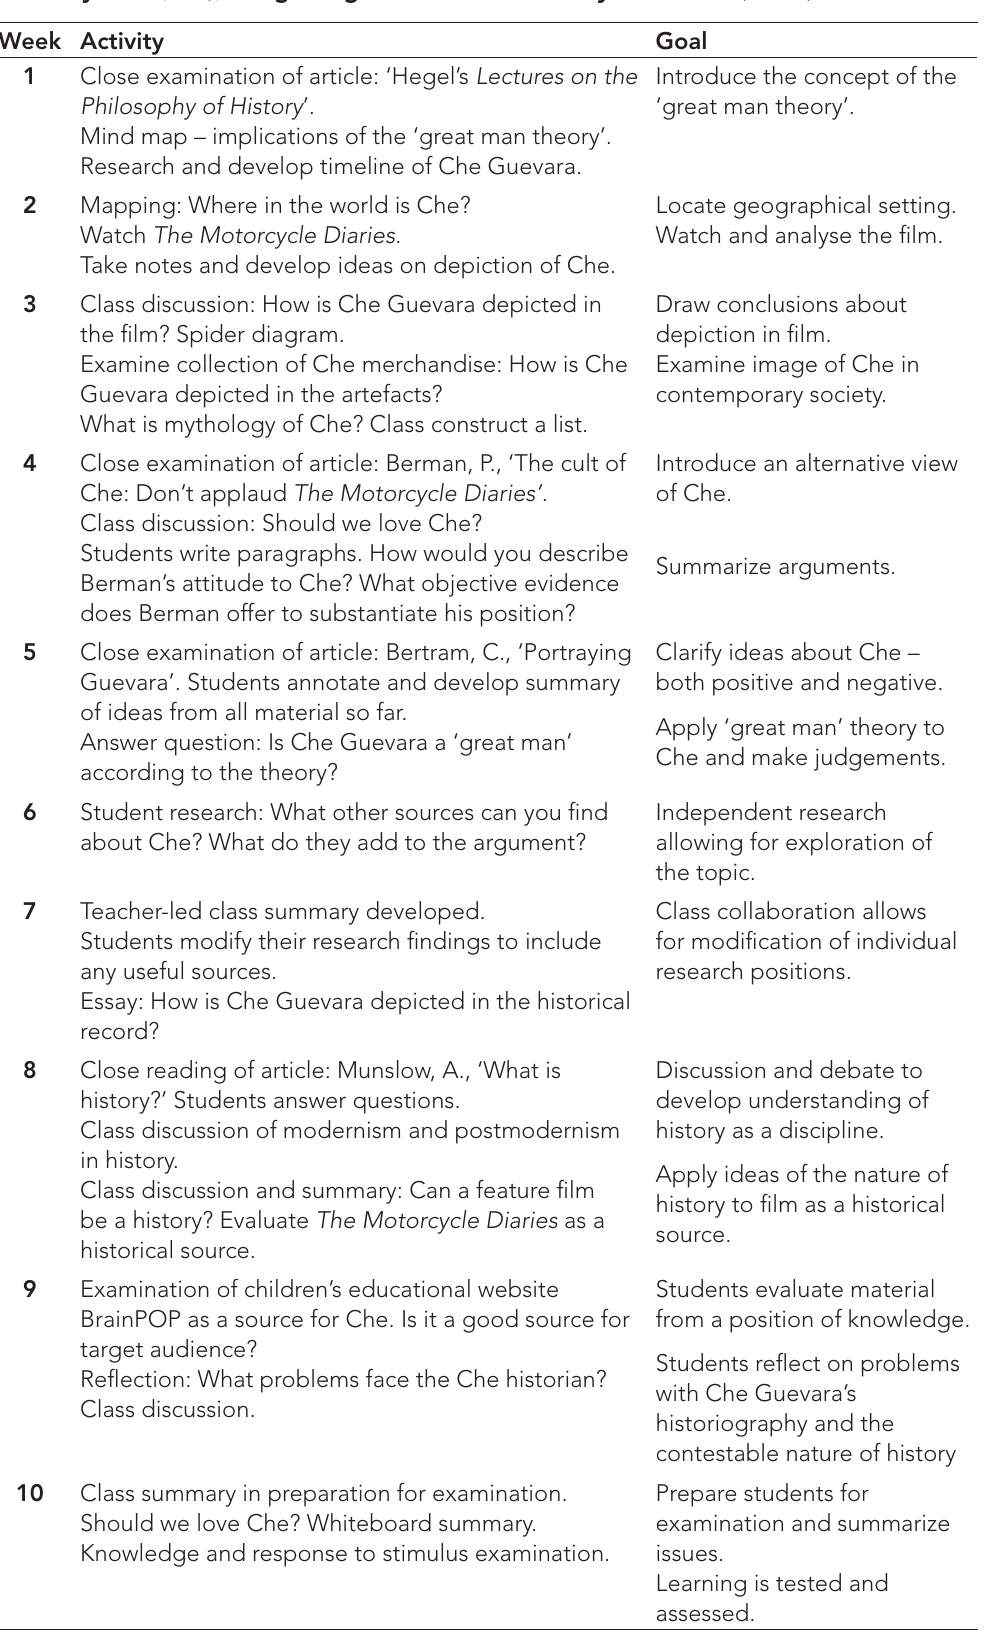
Table 2: Mrs Patterson Stage 6 Year 11 (16–17 year olds) Theme 11: The individual in history: Concept of the great person in history (Queensland Modern History Senior Syllabus, 38), integrating the film The Motorcycle Diaries